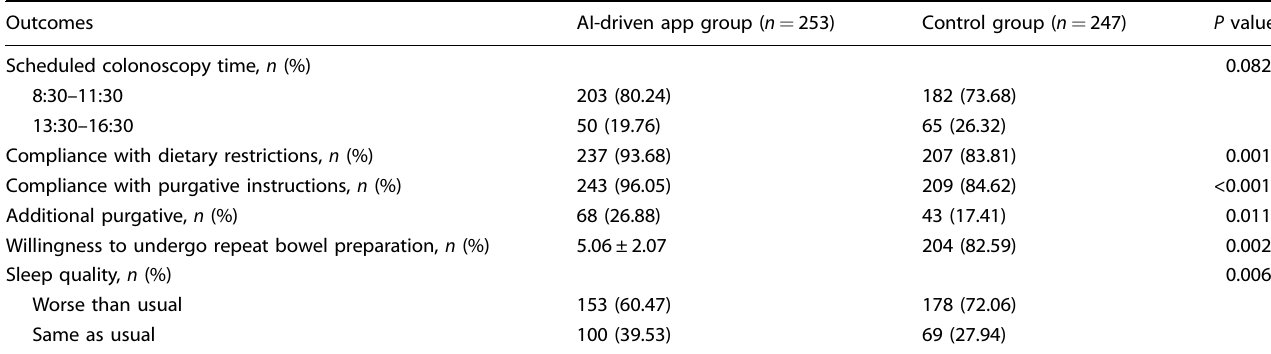
Table 4. Effect of AI-driven app on the procedure of bowel